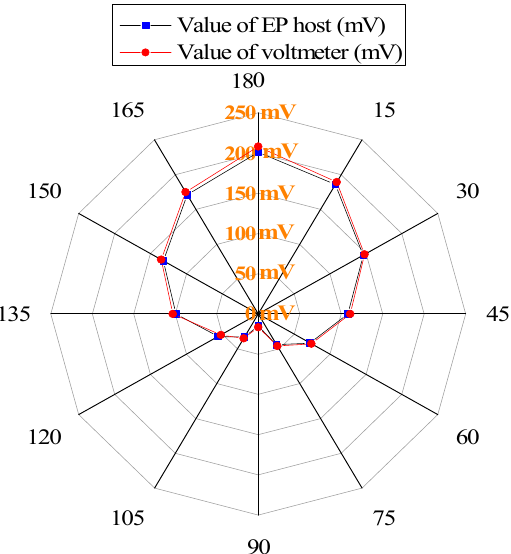
Figure 7. Experiment results of EP measuring in the water bathing environment.